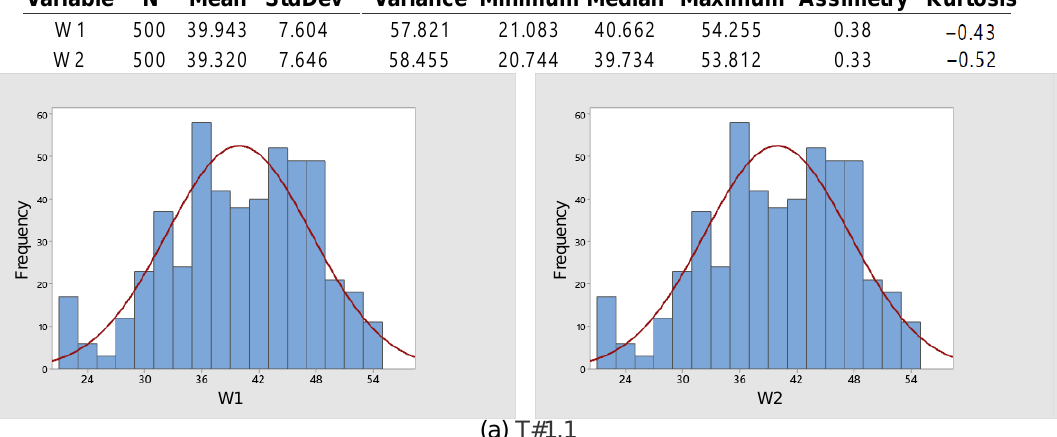
Figure 15. Rotation speed of electric motors and wheel slip during the trial sessions carried out on